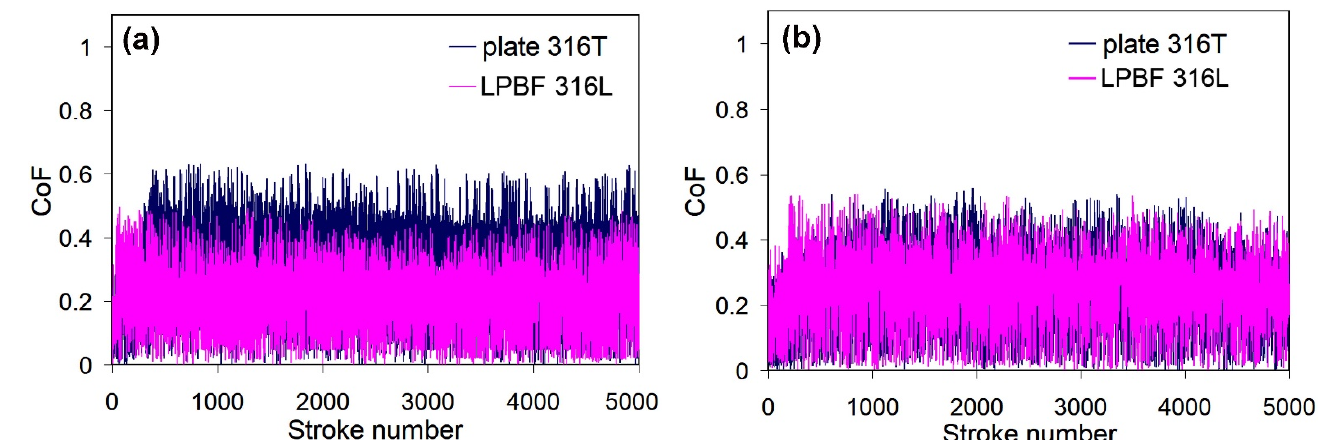
Figure 16. Variation of CoF of the specimens during SBF sliding: ( a ) as-received and ( b ) plasma-treated states.